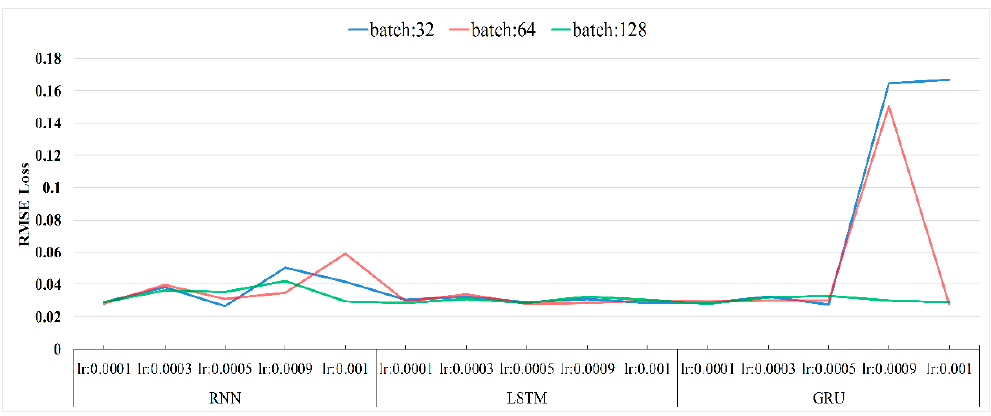
Figure 9. RMSE loss of the three models.